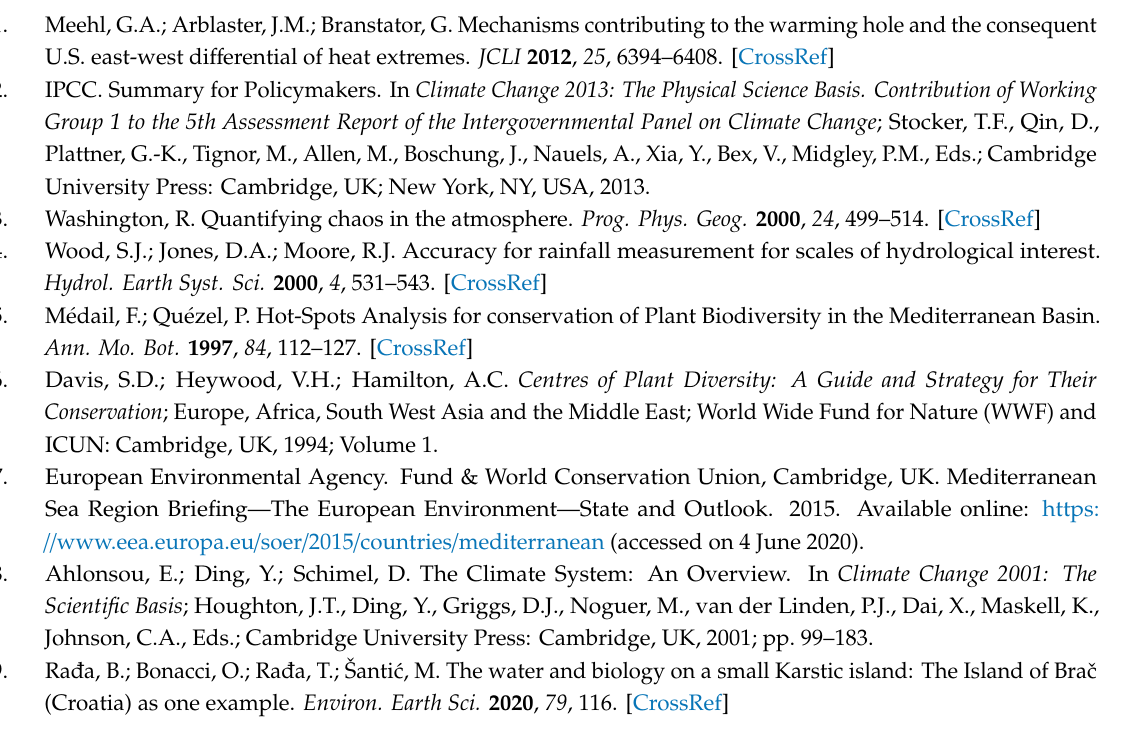
Table S1: Statistics (minimum, average, and maximum) of the monthly minimum, mean, and maximum air temperature at the stations of Lastovo, Komiža, and Palagruža. Table S2: Statistics (minimum, average, and maximum) of the monthly precipitation at the stations of Lastovo, Komiža, Biševo, and Palagruža. Table S3: p -values of the F-test and t -test for the minimum, mean, and maximum annual air temperature. Table S4: p -values of the F-test and t -test for the annual